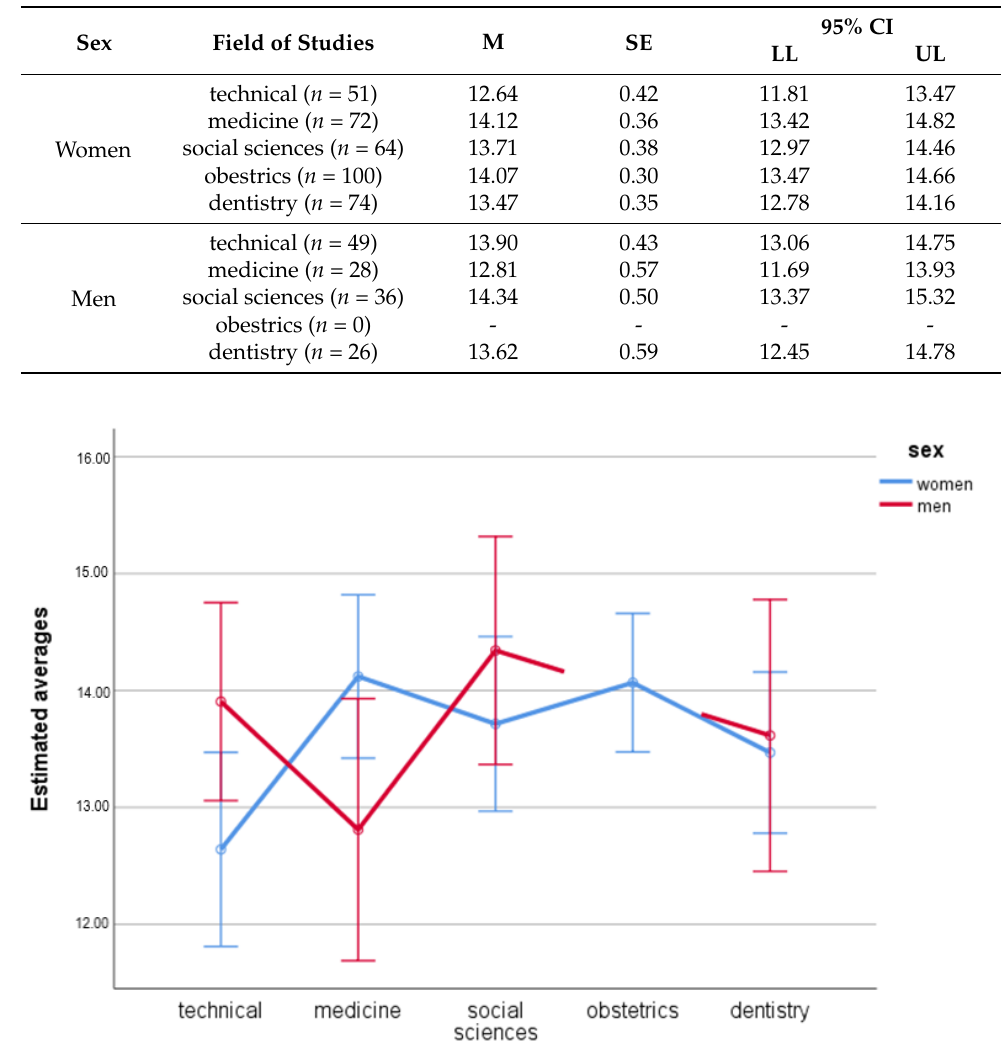
Figure 2. Estimated averages for second domain with regard to sex and field of study.